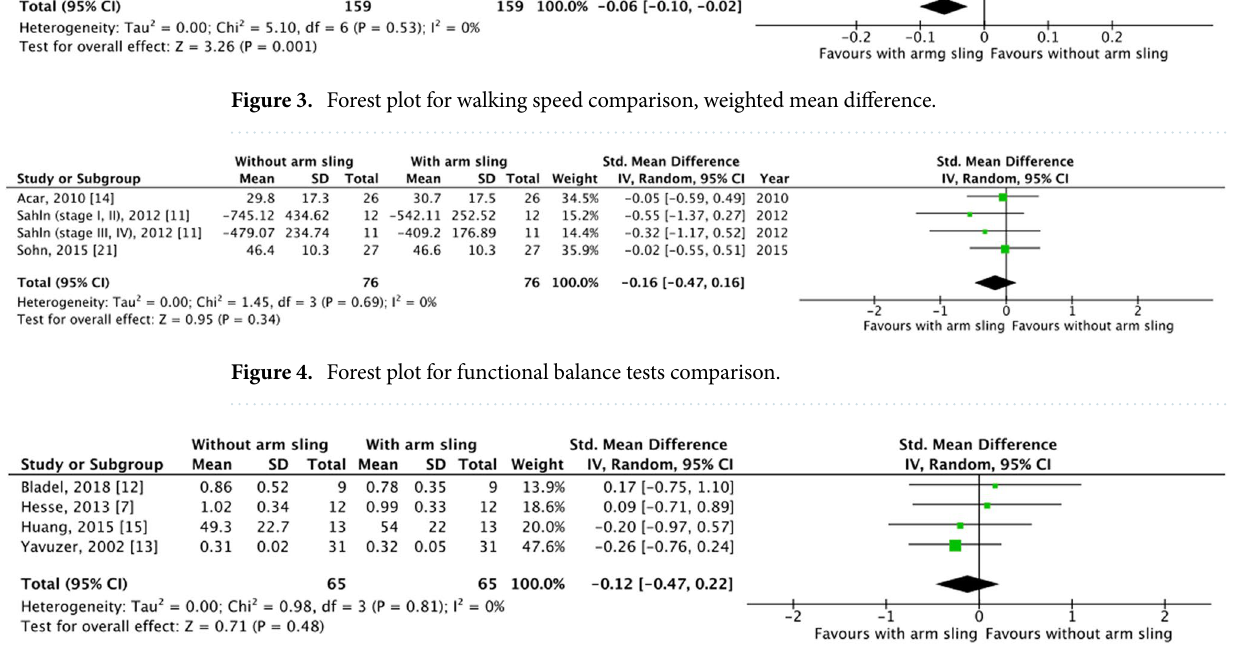
Figure 5. Forest plot for step or stride length comparison.